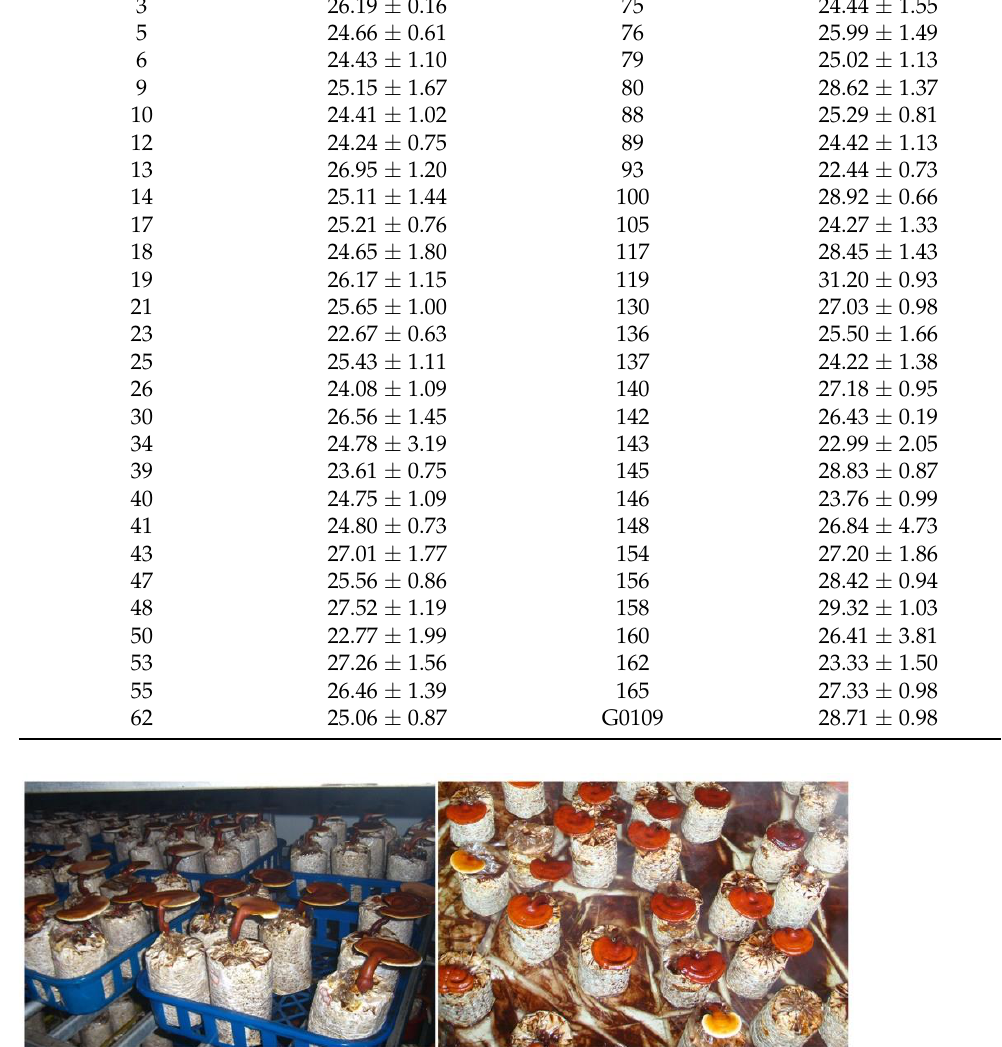
Table 4. Spore unit output (gram per spawn) of some mutagenic strains.